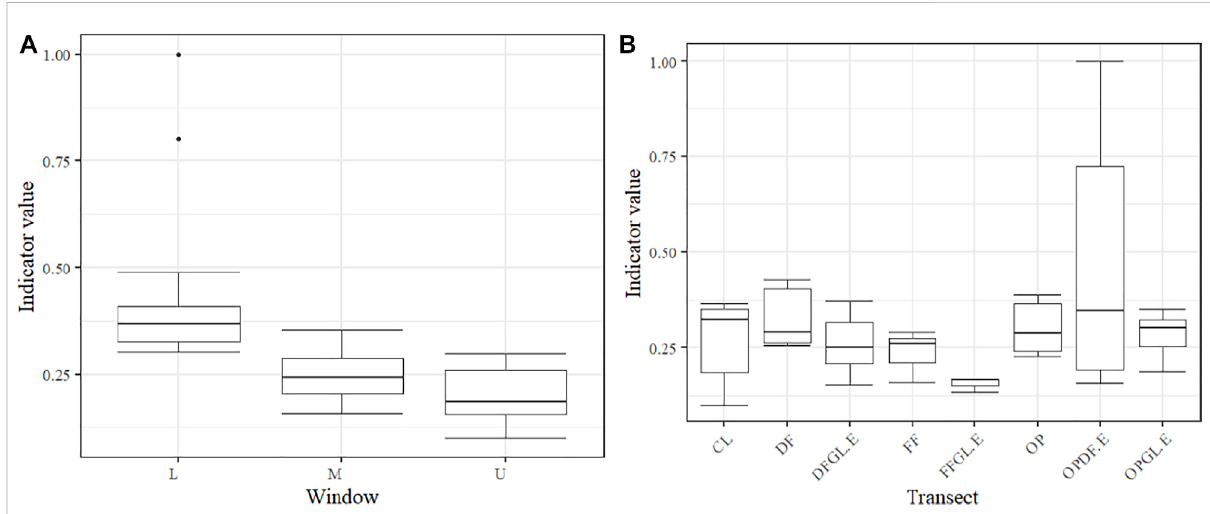
FIGURE 6 Soil ES valuation indicator, Carbon storage, for ESPUs. (A) . Window. (B) . Transects. Orotoy river. FF, Fragmented Forest; DF, Tropical Dense Humid Forest; GL, Cattle Grassland; OP, Oil Palm Plantation. DFGL.E, ecotone DF-GL; OPDF.E, ecotone DF-OP; OPGL.E, ecotone OP-GL; FFGL.E, ecotone FF-GL basin. Source: Elaborated by the authors.